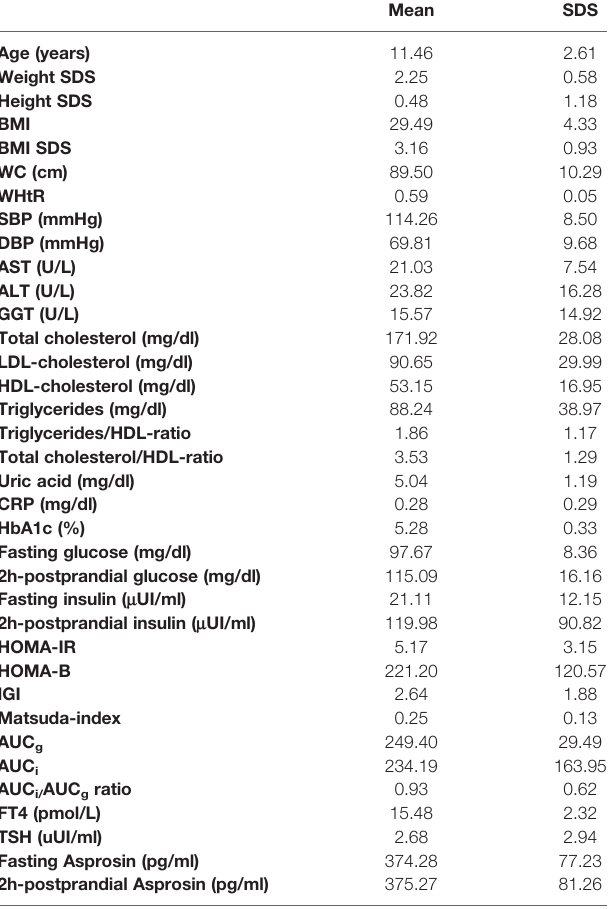
TABLE 1 | Clinical and biochemical features of study